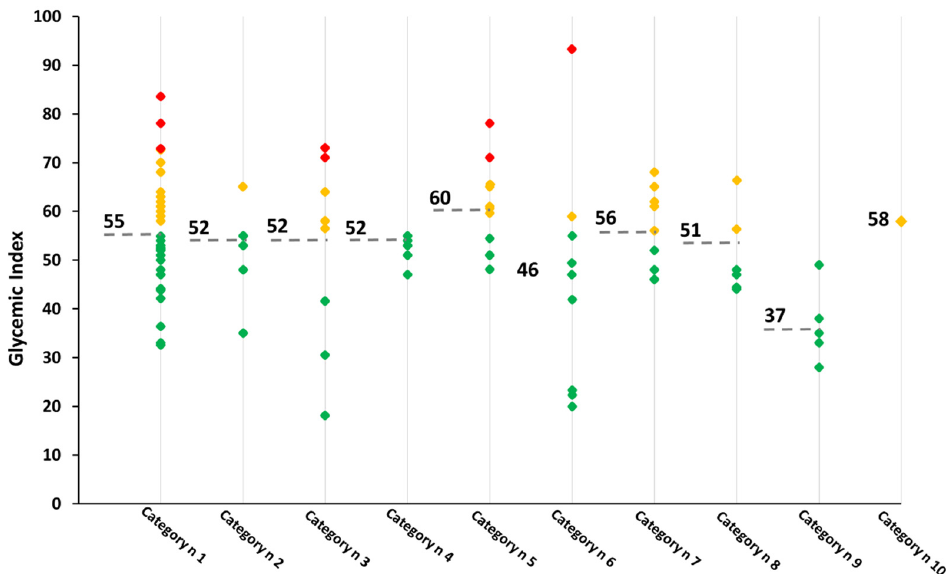
Figure 2. GI values of the 10 categories of pp analyzed. Red diamonds correspond to high GI pp; orange diamonds to medium GI pp; green diamonds to low-GI pp. Values reported in the figure correspond to the mean value for each category. Note: category n 1: 100% refined wheat; category n 2: 100% whole wheat; category n 3: other cereal-based products; category n 4: containing egg; category n 5: gluten free; category n 6: containing legumes; category n 7: noodles and vermicelli; category n 8: containing vegetable or algae; category n 9: containing other ingredients; category n 10: stuffed.